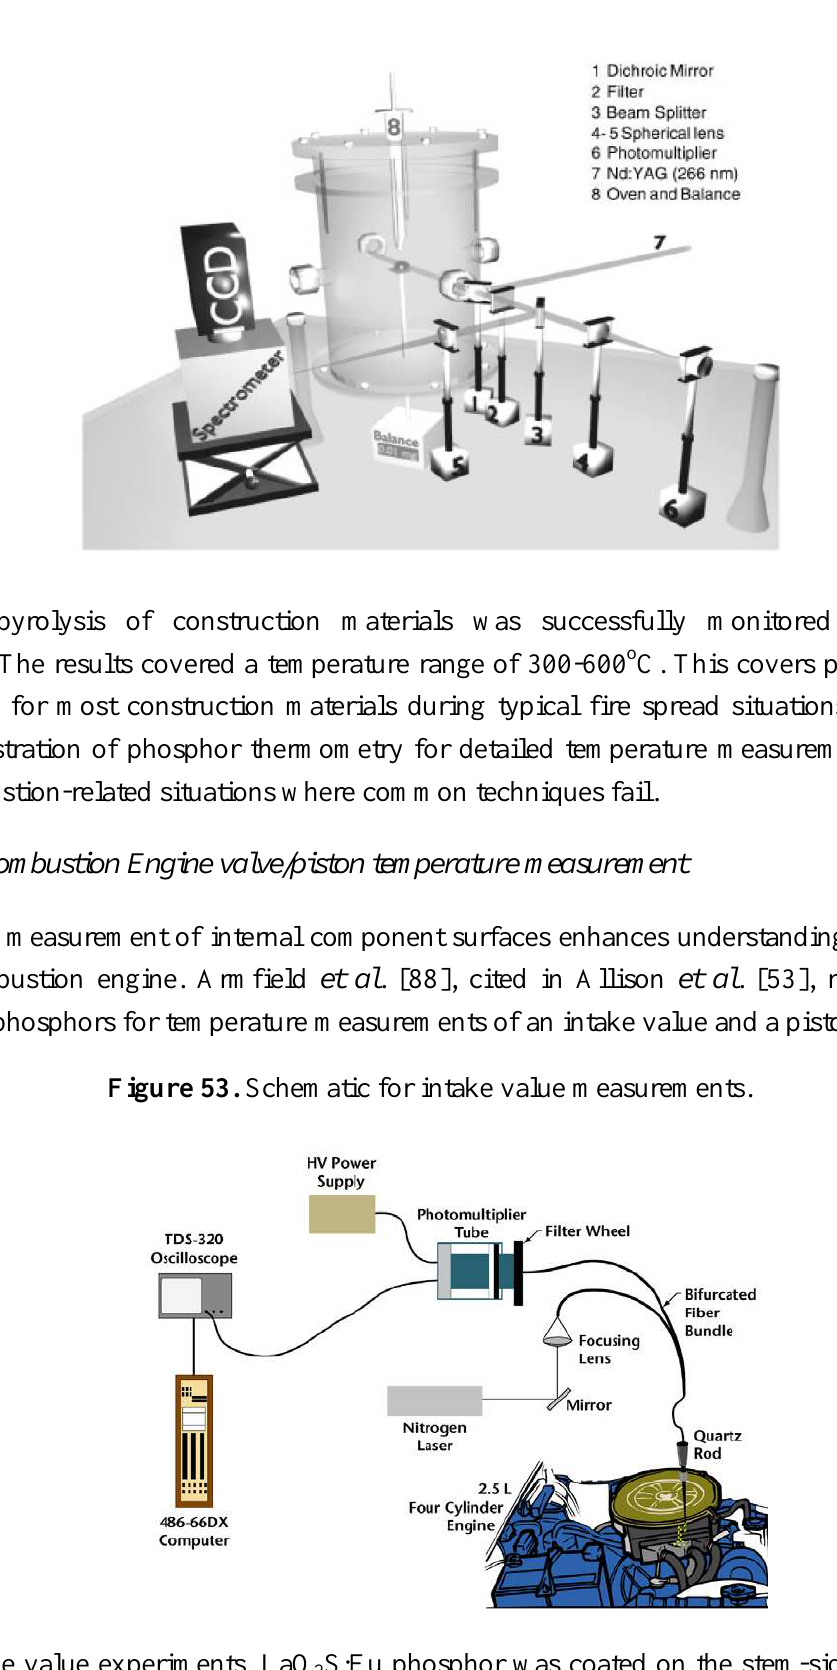
Figure 52. Schematic to study the pyrolysis of construction materials [87].